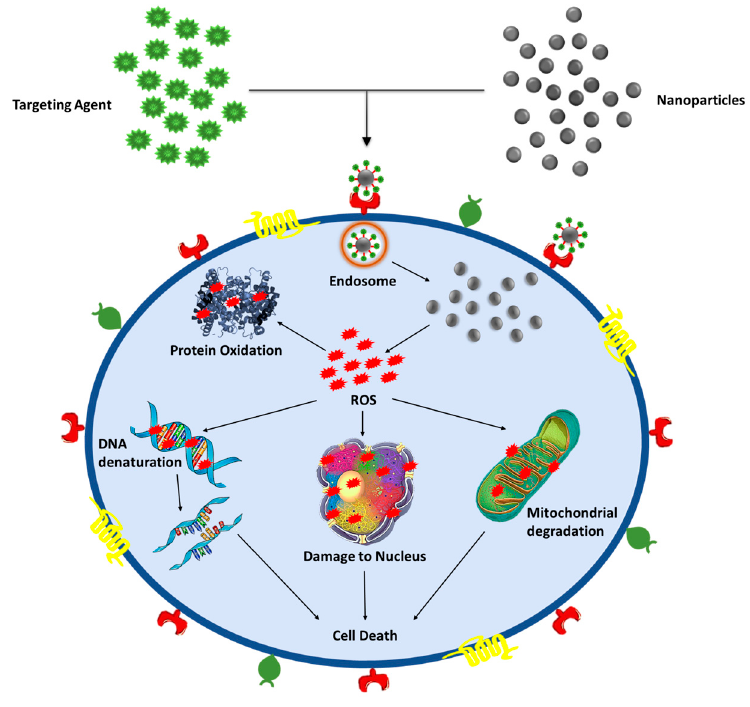
Figure 4. Graphical illustration of the anticancer mechanism of nanoparticles.